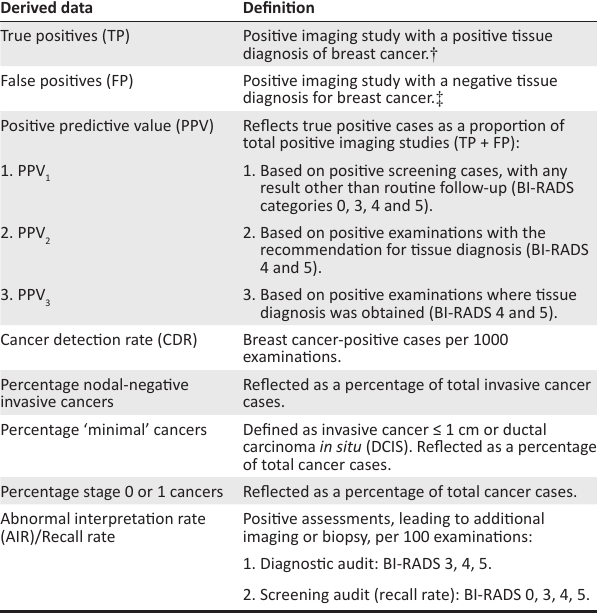
TABLE 2: American College of Radiology breast-imaging reporting and data system audit